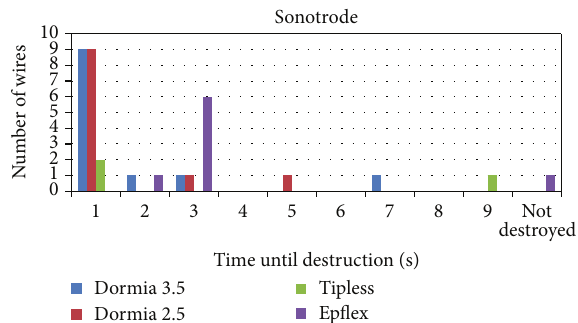
Figure 7: The ultrasonic lithotripter destroyed all baskets wires with the exception of one 2.5 F tipless basket. The destruction took place from 1 to 9 sec.